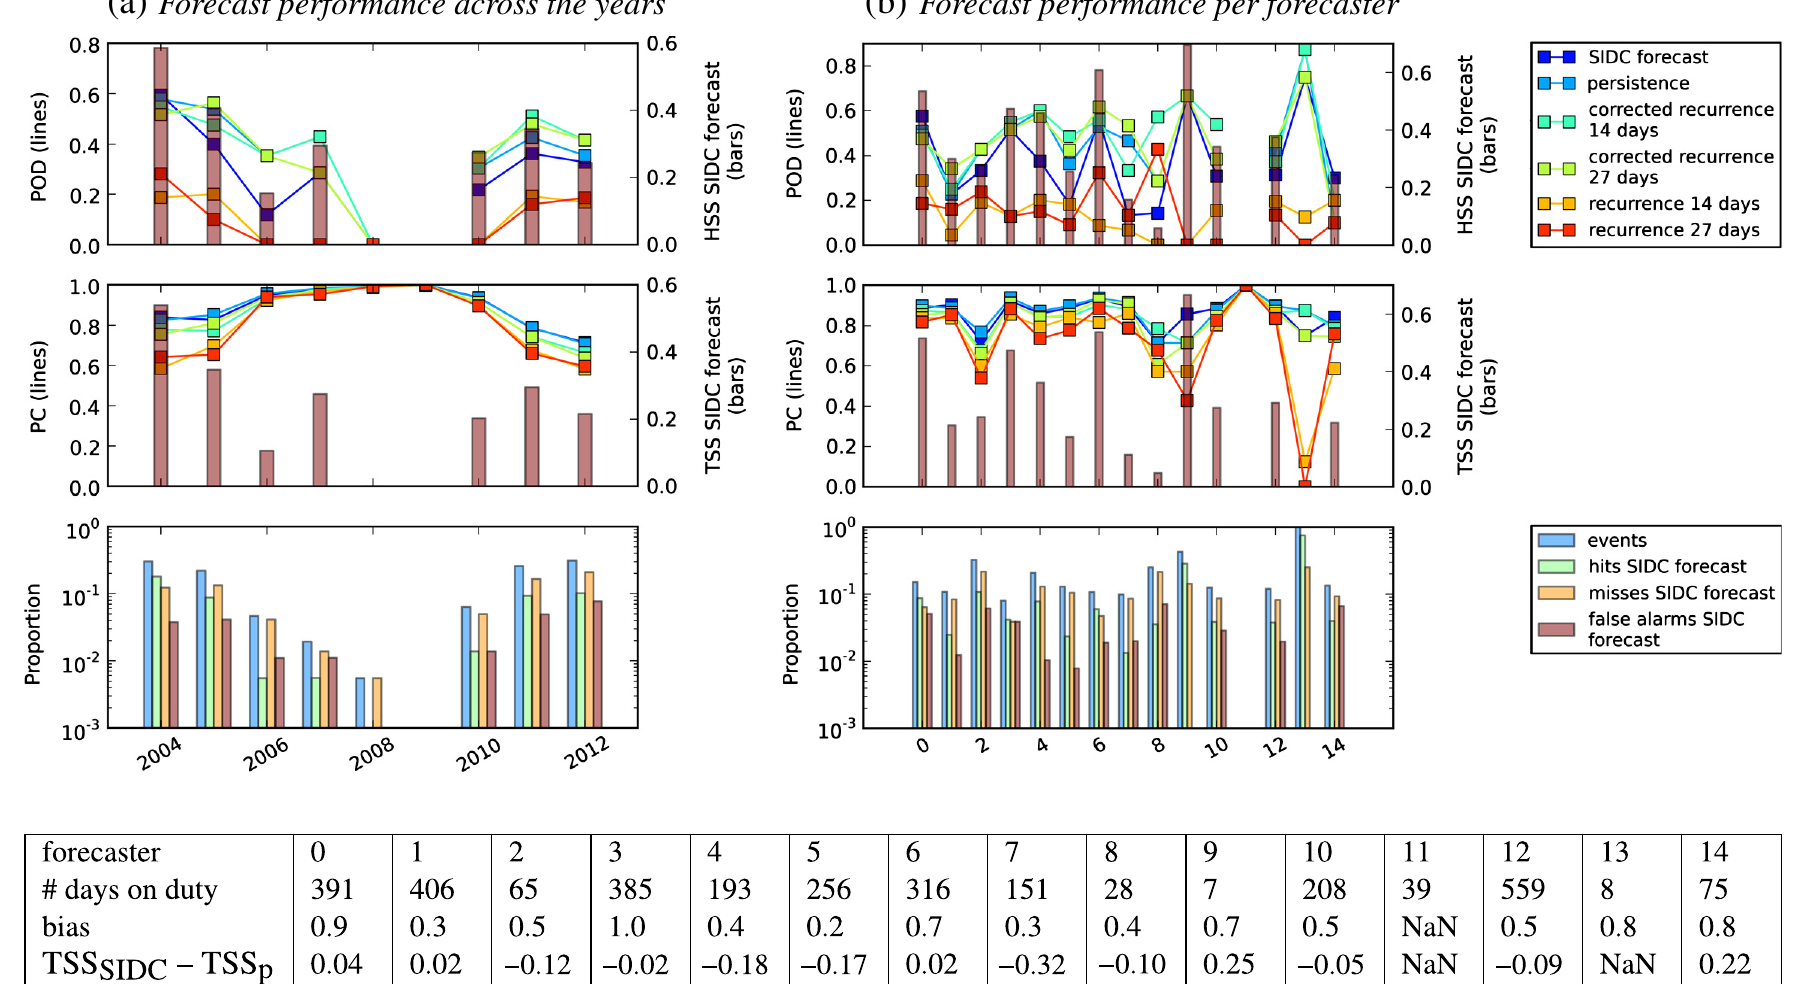
Fig. 5. Evaluation of the SIDC forecast and models to predict anX-ray flare of classes M or X, across theyears (a) and for each individual forecaster (b). The following description holds for both plots. Top panel : POD (lines, left vertical axis, Eq. (5)) and HSS (bars, right vertical axis, Eq. (10)). Middle panel : PC (lines, left vertical axis, Eq. (6)) and the TSS (bars, right vertical axis, Eq. (11)). POD and PC are shownforallforecasts,whileHSSandTSSareonlyfortheSIDCforecast. Bottompanel :theproportionofdayswithanevent,ahit,amissandafalsealarm(onalogarithmicscale).Theproportionofhitsand theproportion ofmissessum up totheproportionofevents. The numberof days on duty, thebias and thedifferenceoftheTSS with theTSS ofthepersistencemodel arementioned for eachforecaster in the table below the figure. Note that some verification measures can not be calculated and are left undefined in case of lack of events or hits (e.g. year 2009 and forecaster